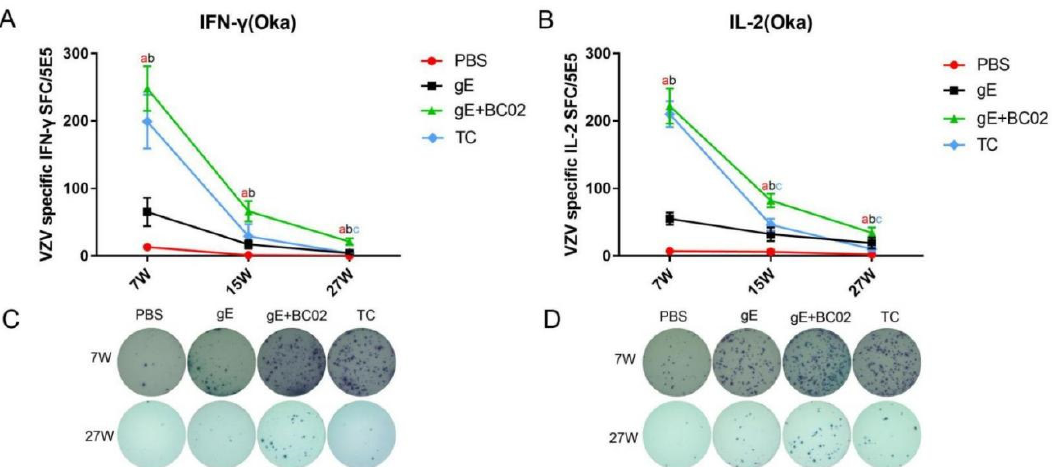
Figure 3. BC02-adjuvanted experimental vaccine induced Oka-specific cellular immune response . ( A , B ) Mean numbers of Oka-specific IFN- γ and IL-2 spot forming cells (SFC) in differently immunized mice 7, 15, or 27 weeks post immunization determined by ELISpot. Six mice per immunization group. ( C , D ) Representative images of Oka-specific IFN- γ and IL-2 secreting T cells in mice 7 and 27 weeks post-immunization with the BC02-adjuvanted gE glycoprotein. a,b,c: Indicates significant statistical difference between gE+BC02 and PBS, gE or TC, respectively. p < 0.05. TC is the abbreviation of test control.